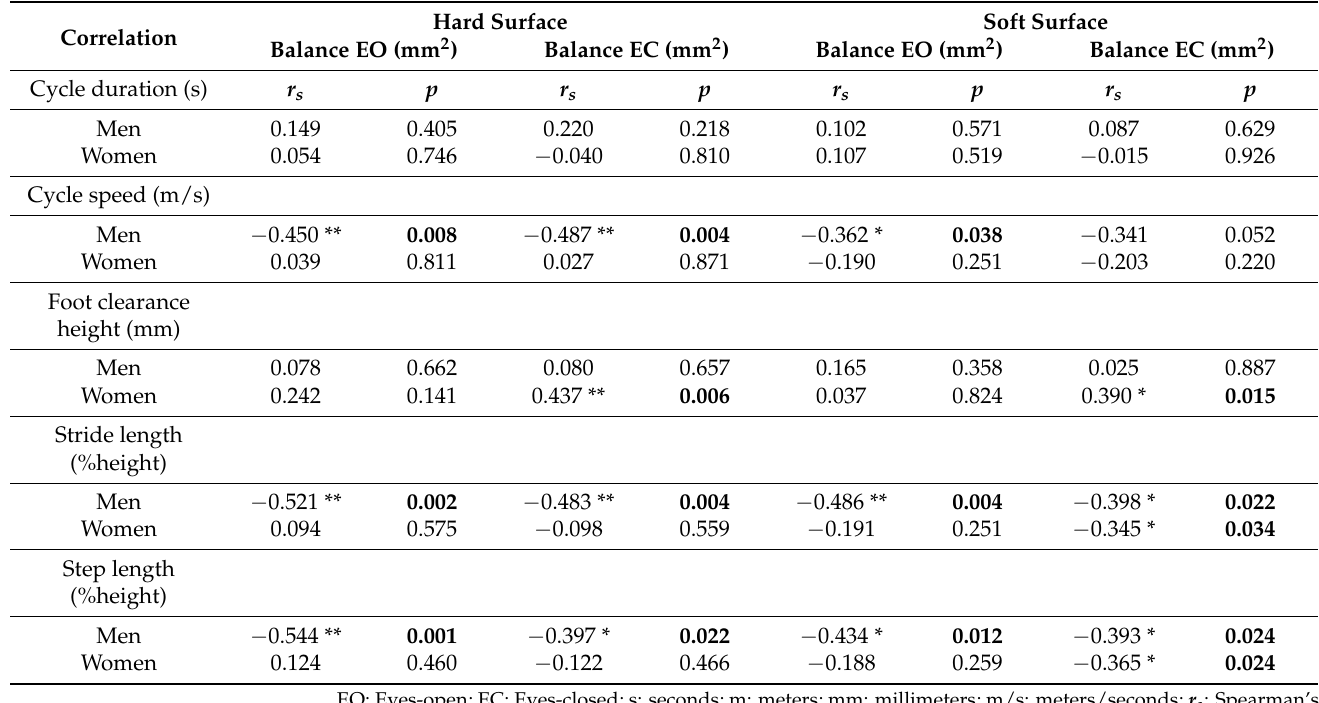
Table 3. Correlation between postural balance and gait parameters in the older population of the present study.